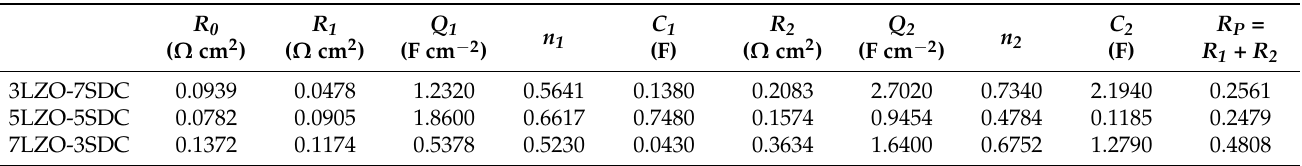
Table 1. The equivalent-circuit analysis results performance of the LZO-SDC SOFCs with various compositions at 550 ◦ C, respectively.